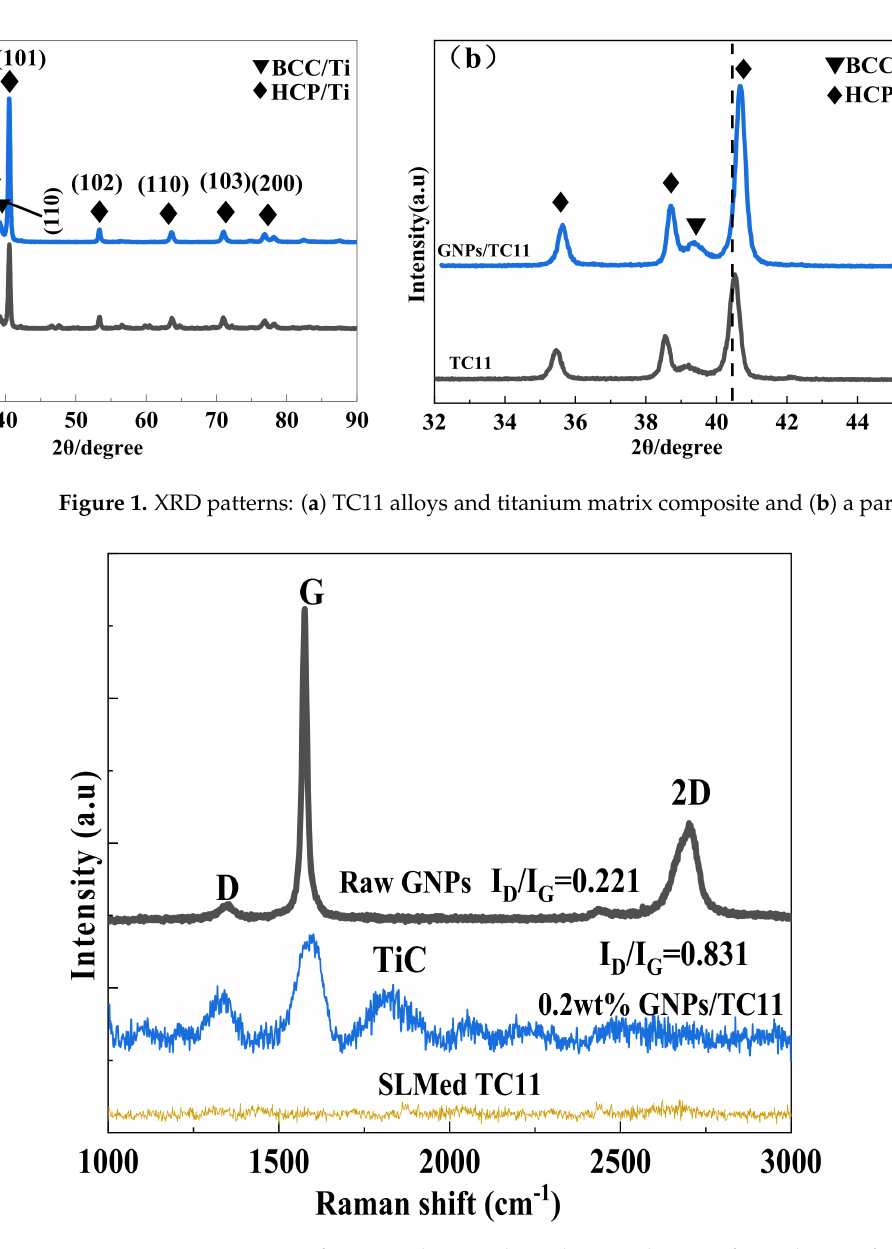
Figure 2. Raman spectra of raw graphene and graphene in the SLM-formed GNPs/TC11